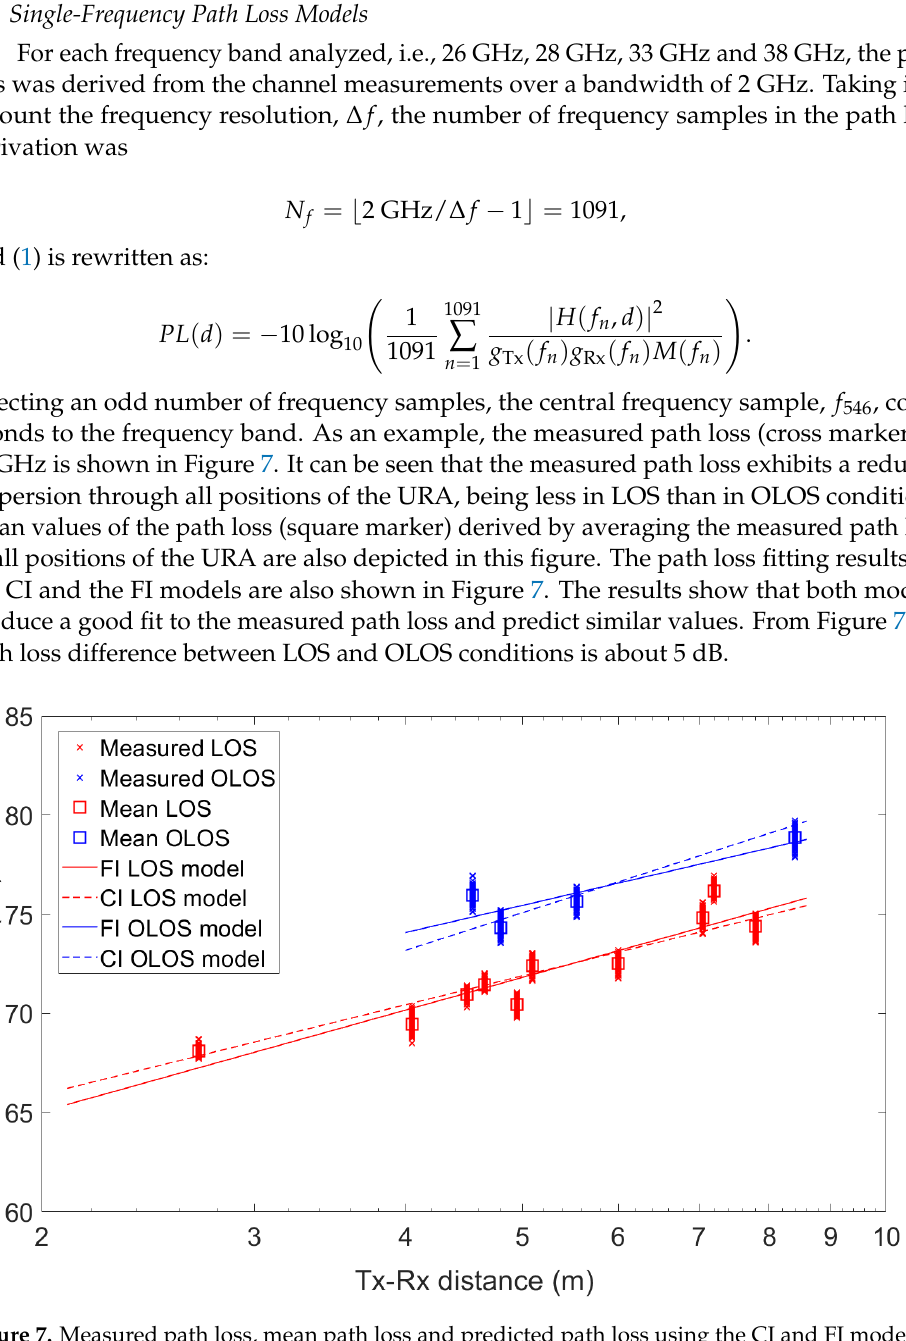
Figure 7. Measured path loss, mean path loss and predicted path loss using the CI and FI models at 28